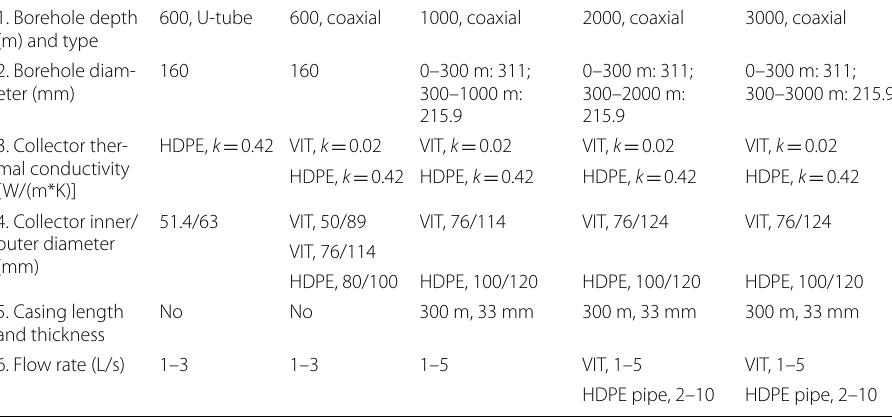
All borehole and pipe diameter values are from the Drilling data handbook (Gabolde et al., 1999)